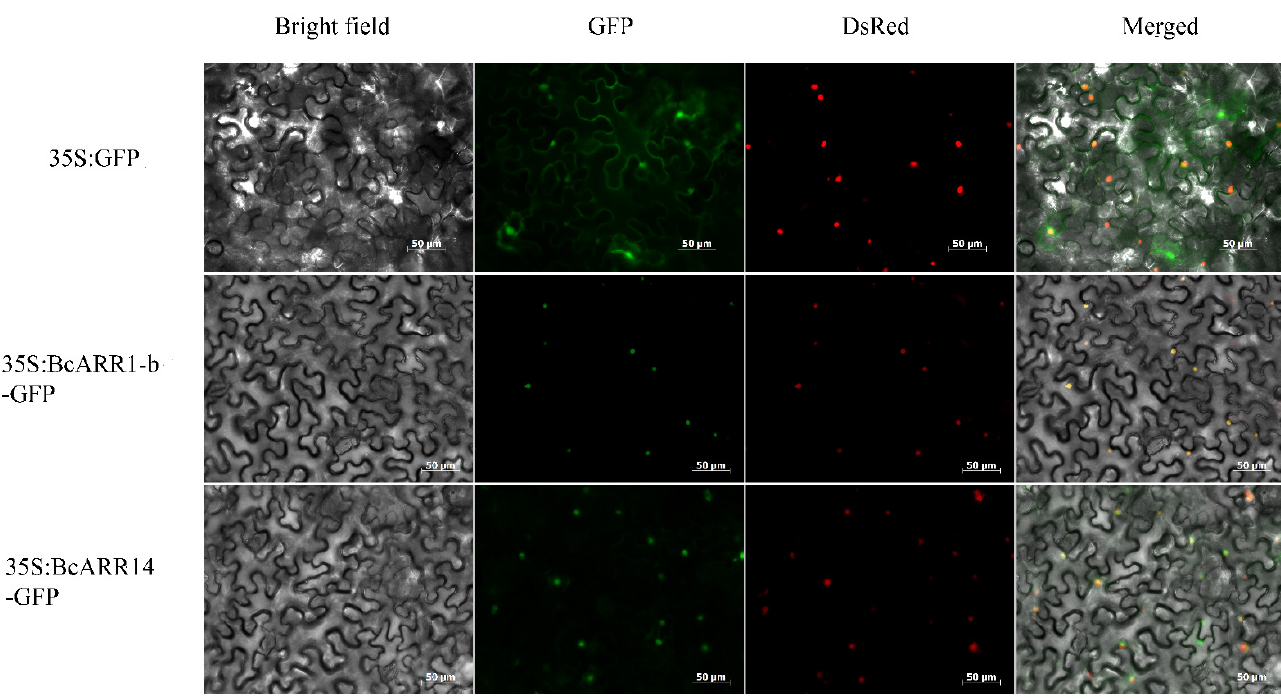
Figure 6. Subcellular localization of BcARR1-b and BcARR14 in Nicotiana benthamiana . BcARR1-b and BcARR14 were fused to N-terminus of the hGFP. BcARR1-b/BcARR14-GFP fusion proteins were transiently expressed in leaves of Nicotiana Benthamiana and subcellular localization was analyzed by microscopy. The merged pictures of green fluorescence channel (middle panels), the red fluorescence channel (middle panels) and the corresponding bright field (left panel) are shown (right panels). The scale bar indicates 50 μ m. The nuclei were stained with DsRed.